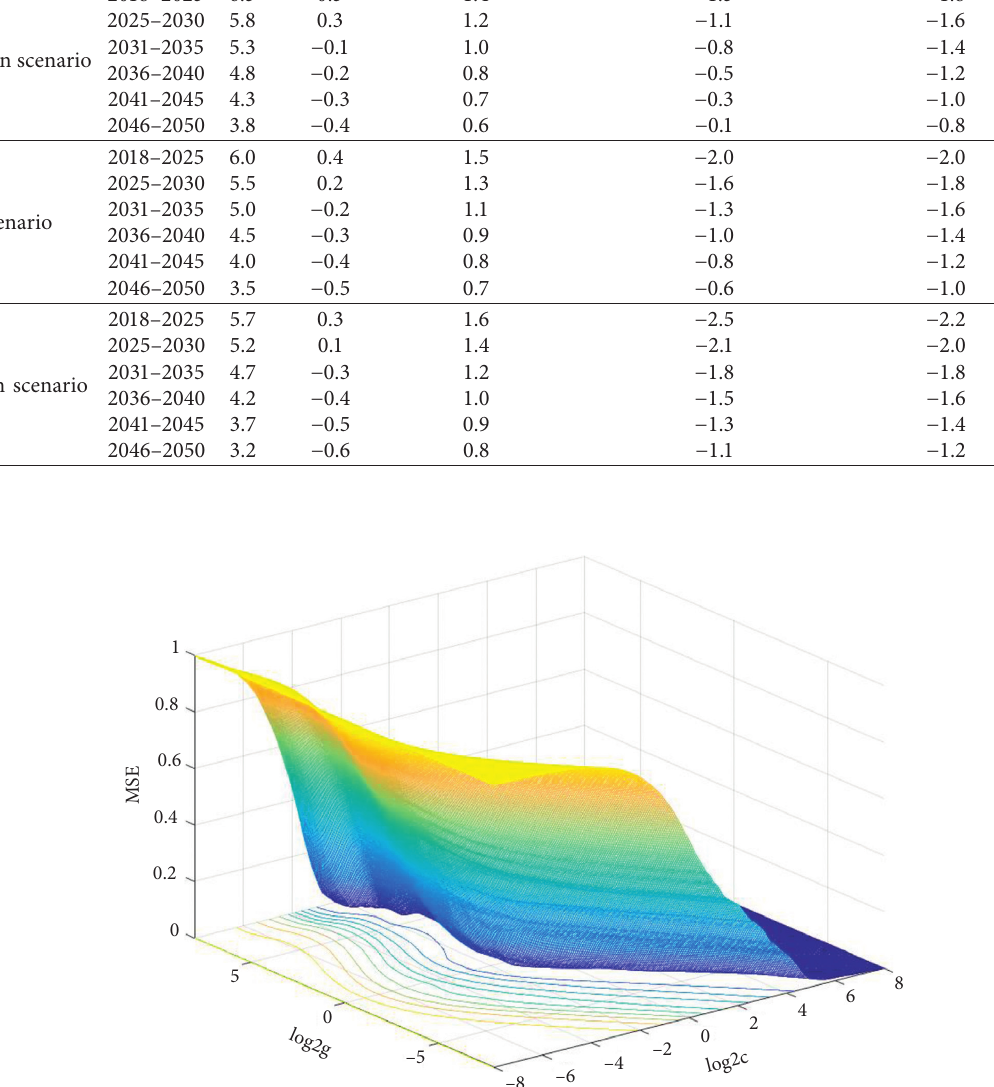
Figure 5: The effect diagram for parameter selection of grid algorithm